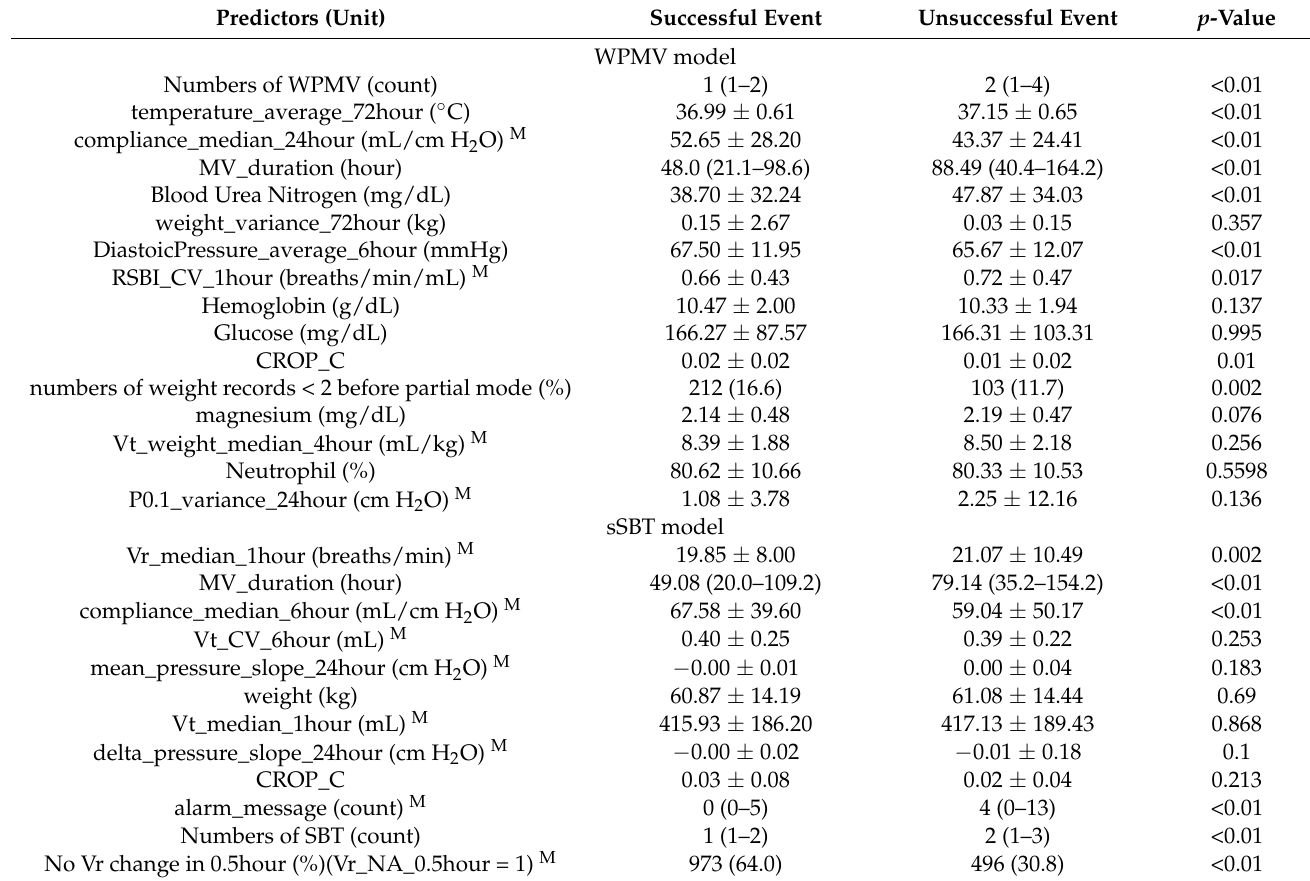
Table 3. Summary of selected predictors of the developed model with successful and unsuccessful